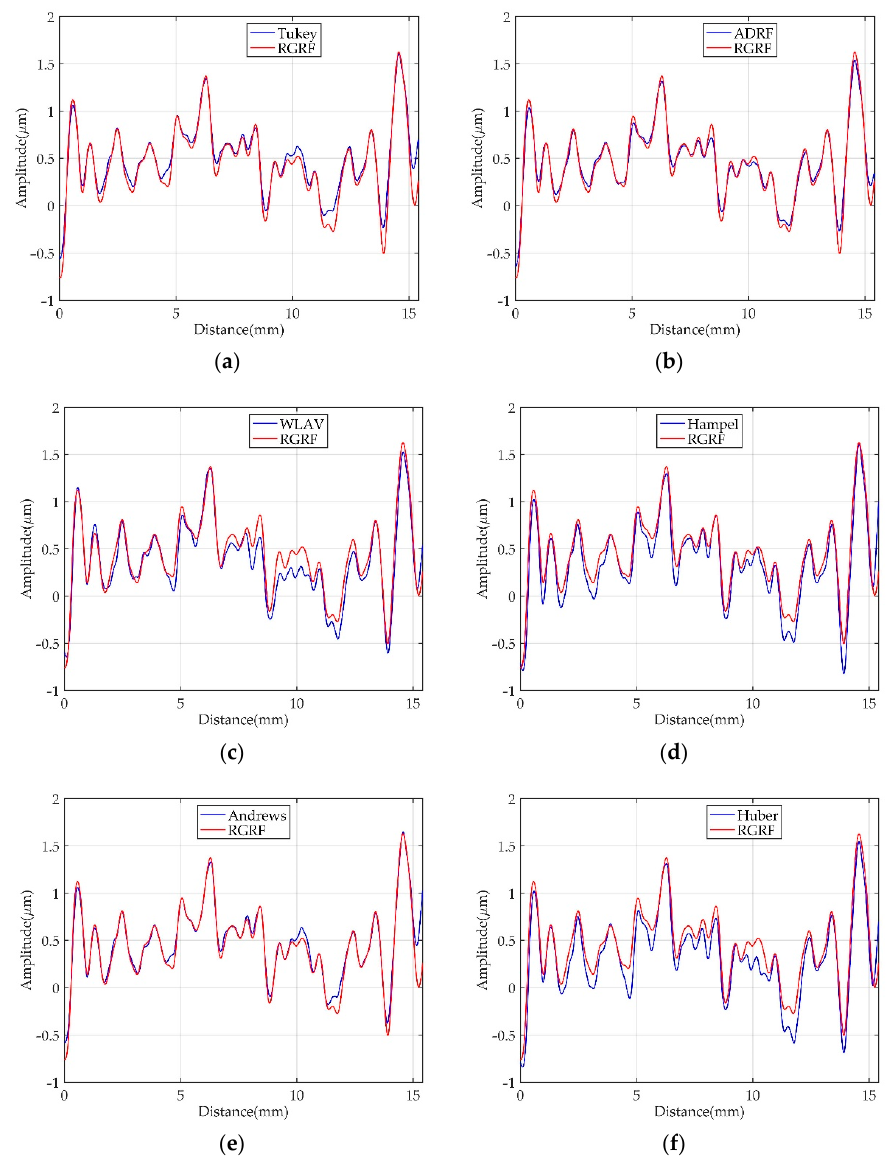
Figure 12. The output waviness profile of the robust Gaussian regression filter and robust approximating spline filter ( a ) Tukey, ( b ) ADRF, ( c ) WLAV, ( d ) Hampel, ( e ) Andrews, ( f ) Huber.